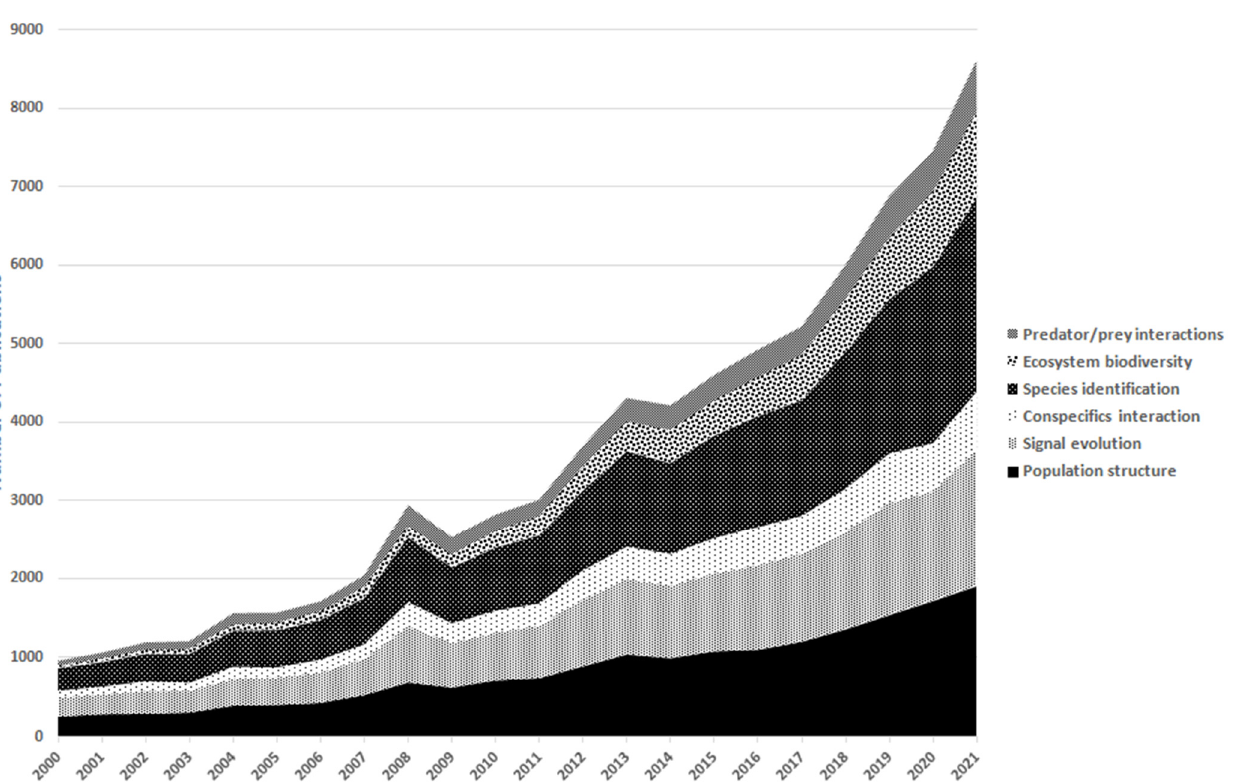
Figure 1. Number of studies performed each year using passive acoustic data. Data were obtained by searching Google Scholar using “bioacoustics” + “category description” and then filtered per